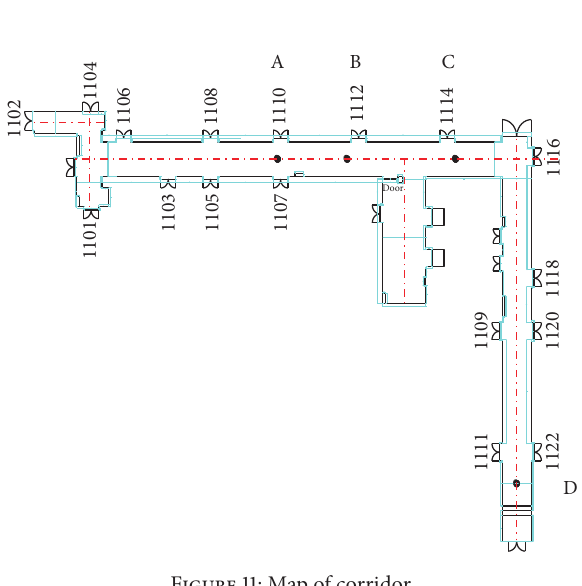
Figure 11: Map of corridor.